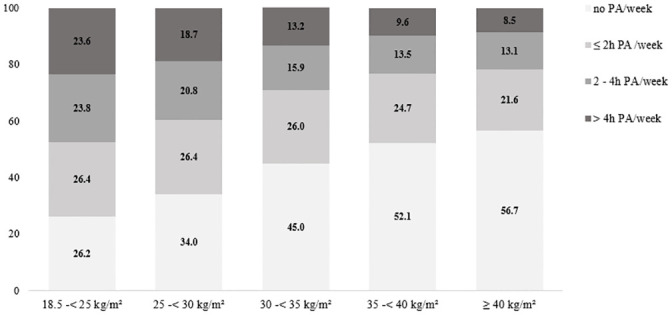
Percentage distribution of PA categories (frequencies) for the BMI sample.